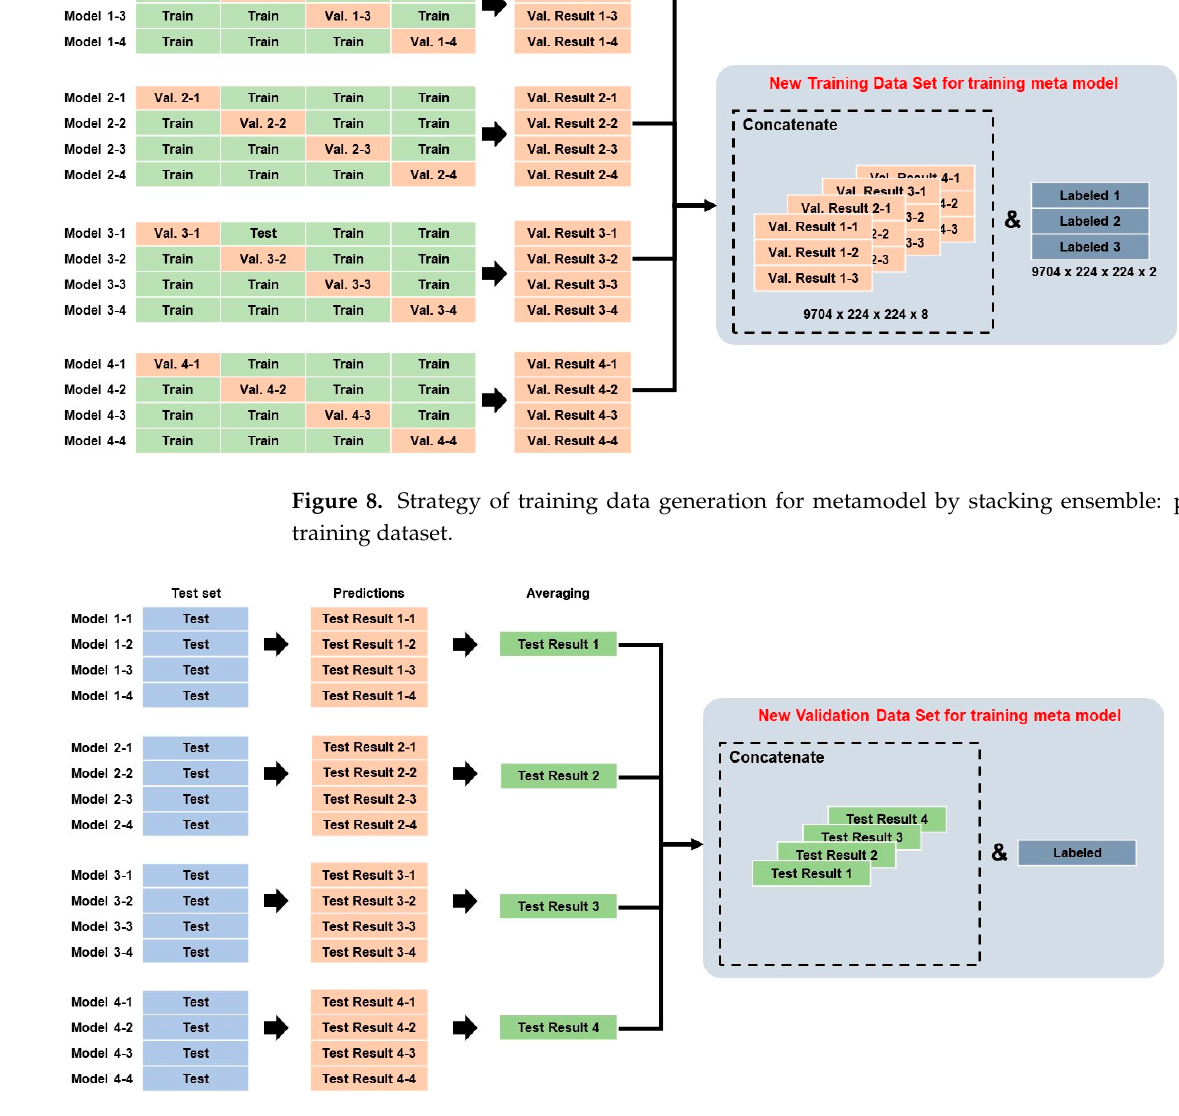
Figure 9. Strategy of training data generation for metamodel by stacking ensemble: preparing test dataset.